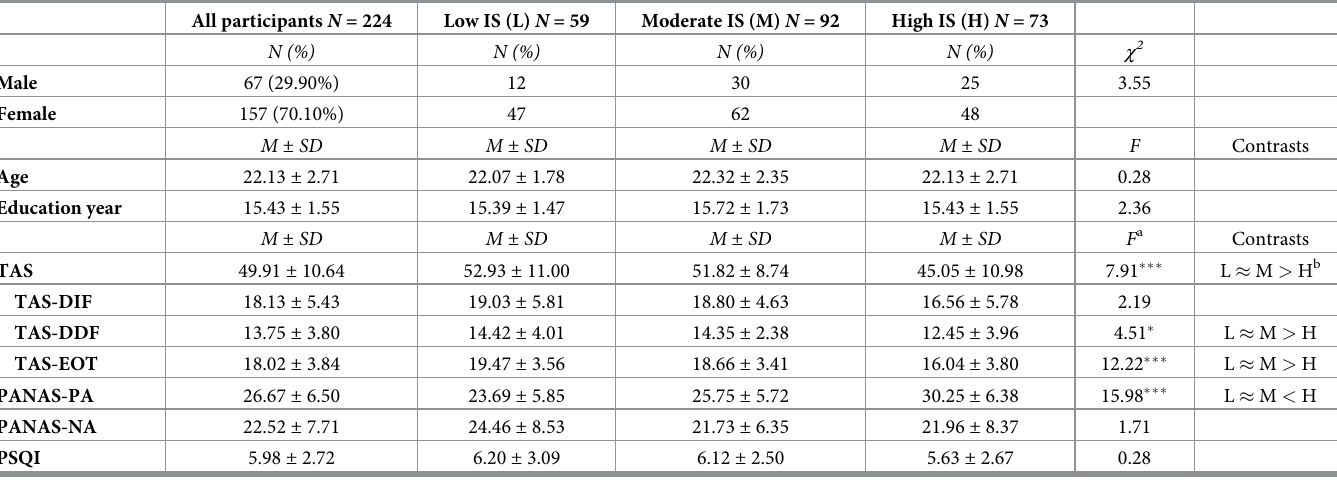
Table 2. Sample characteristics and differences of measures between three IS